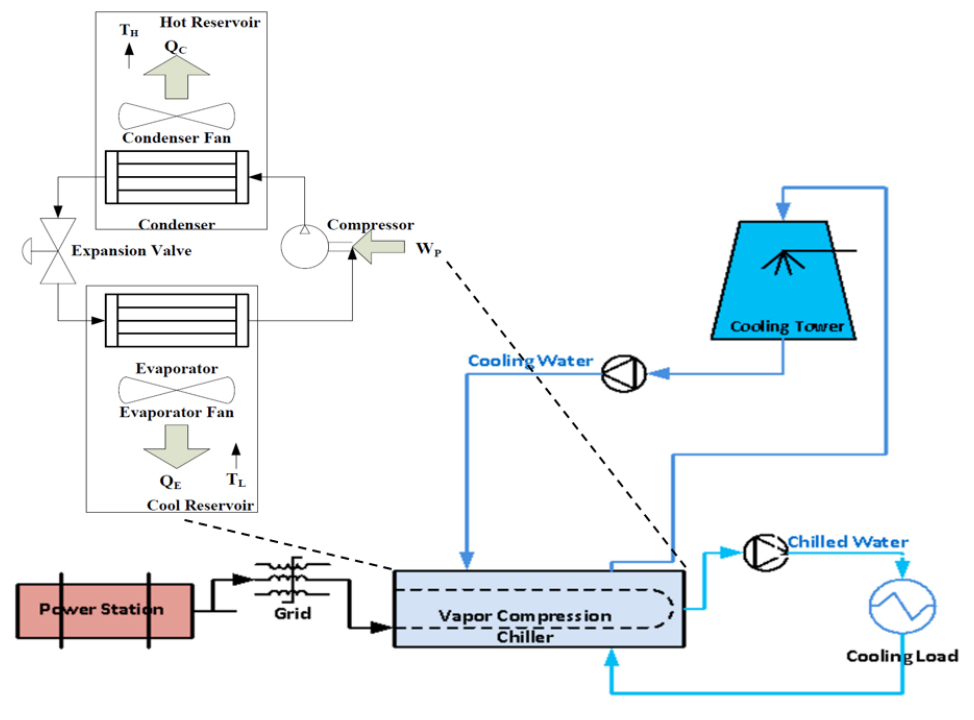
Figure 1. Schematic diagram of the basic cycle of a vapour compression refrigeration